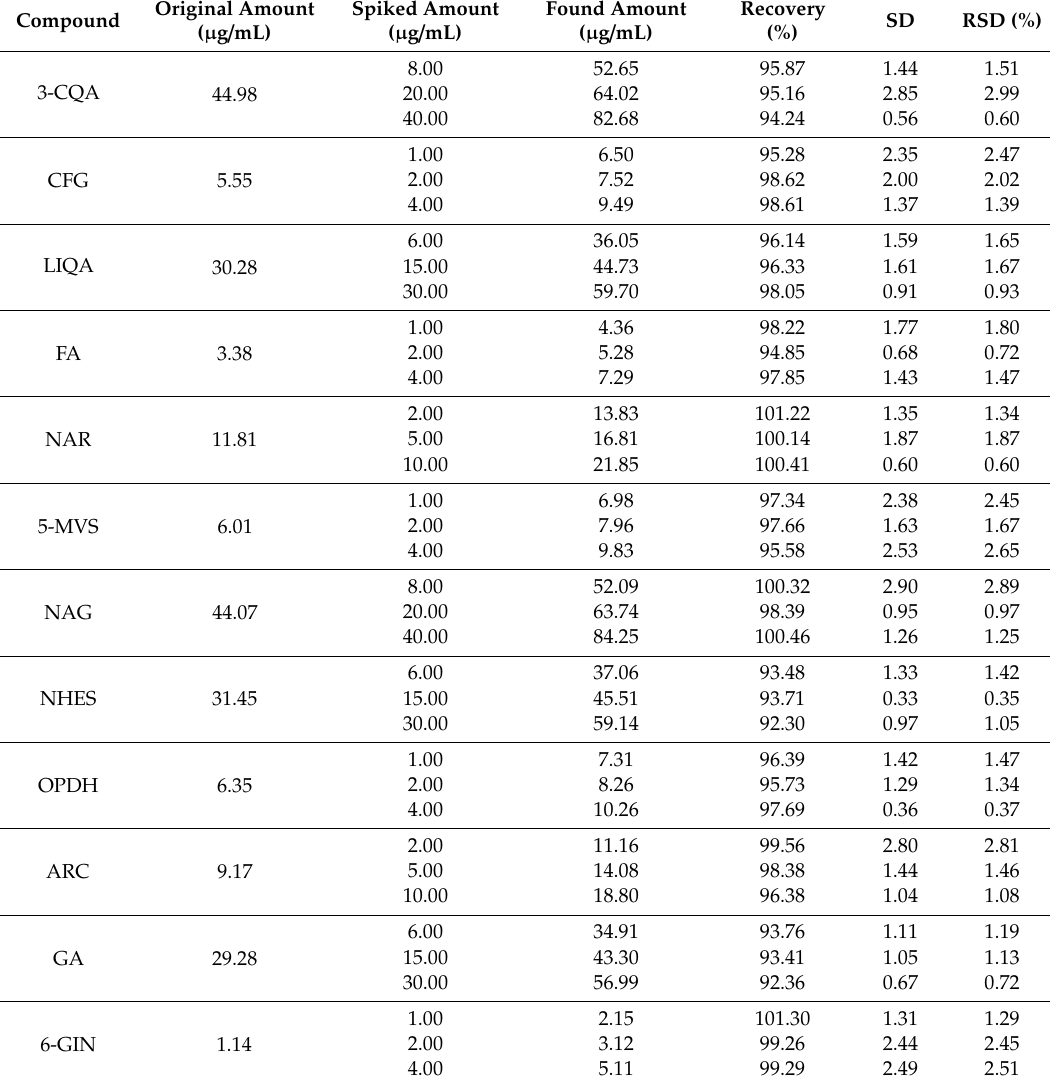
Table 2. Recovery test for the assay of 12 components in YPS using